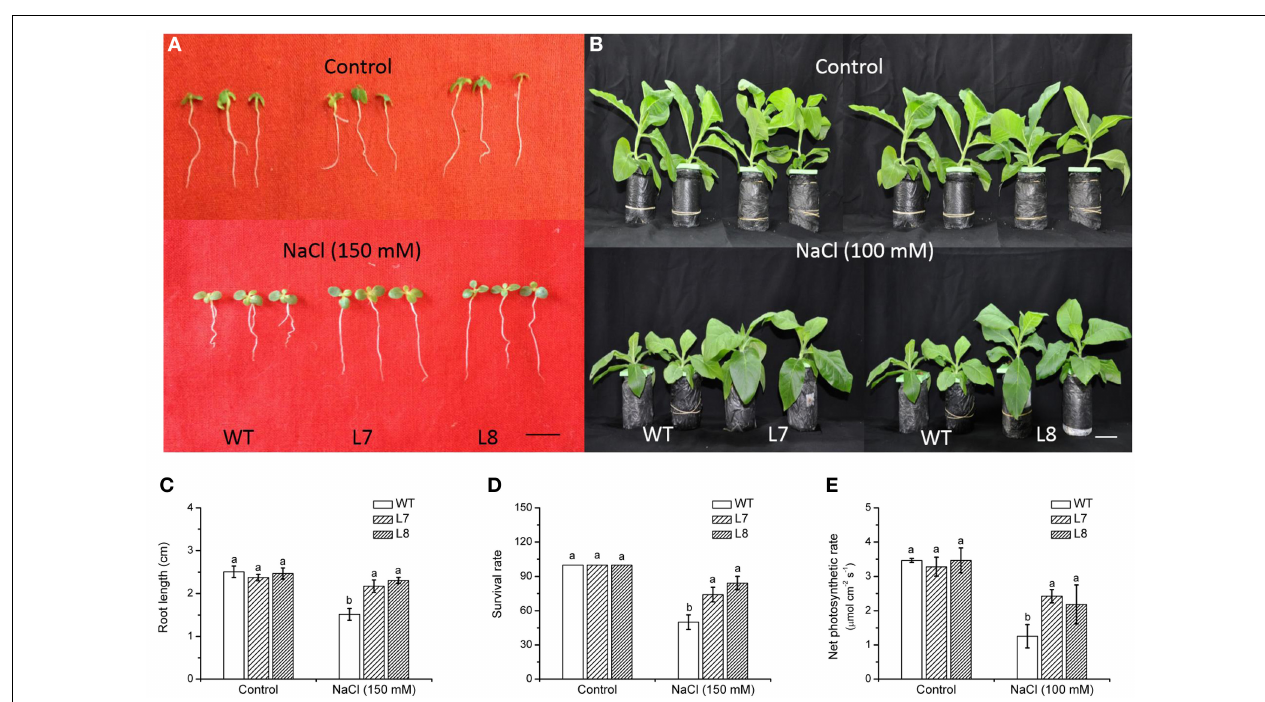
FIGURE 6 | NaCl tolerance of wild-type tobacco and KcCSD -transgenic lines. Seeds of wild-type (WT) and transgenic lines (L7 and L8) were germinated on MS medium for 7 days, then supplemented with 0 or 150mM NaCl for another 7 days. (A,C,D) Show root growth and survival rate of tobacco seedlings. (B,E) Show plant performance and net photosynthetic rate of tobacco plants after exposure to 0 or 100mM NaCl for 7 (E) or 14 (B)